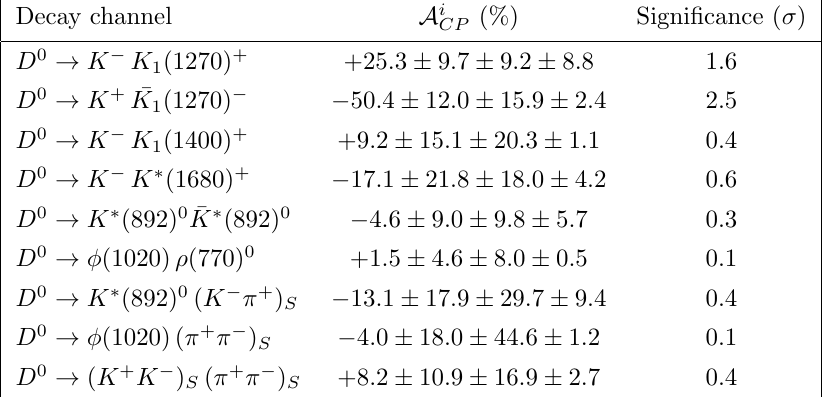
Table 8 . Direct CP asymmetry and signi(cid:12)cance for each component of the D 0 ! K + K (cid:0) (cid:25) + (cid:25) (cid:0) LASSO model. The (cid:12)rst uncertainty is statistical, the second systematic and the third due to alternative